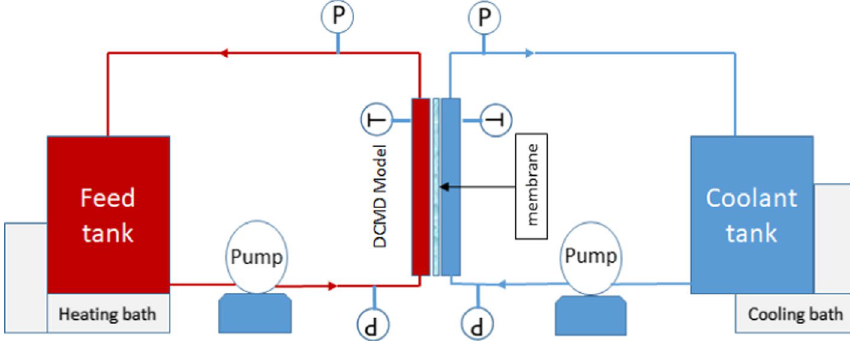
Fig. 2 Direct contact membrane distillation